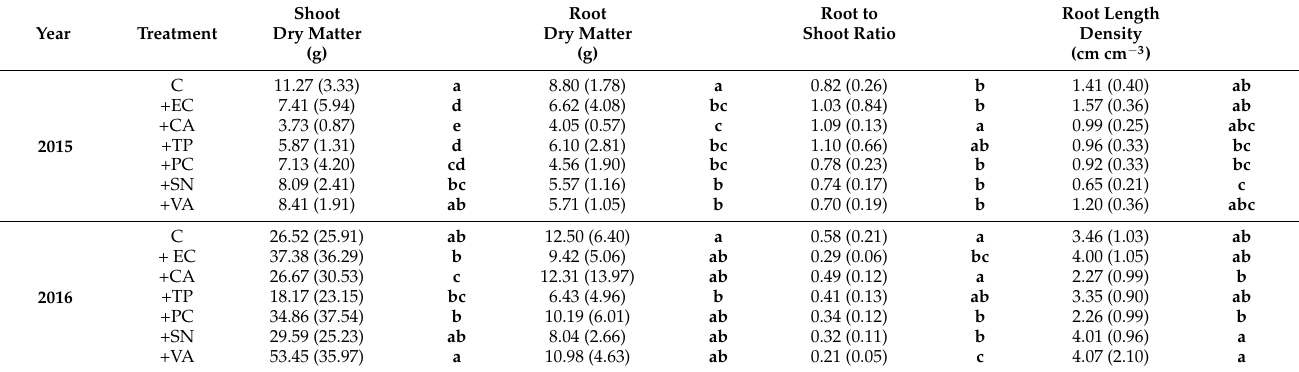
Table 2. Maize growth parameters (mean with standard deviation in parentheses) in weed-free growth (C) and mixed growth with weeds (+EC, +CA, +TP, +PC, +SN, +VA) in a pot experiment under semi-field conditions for 12 weeks at a P deficient soil in Northern Germany in 2015 and 2016. Lower letters indicate significant differences ( p < 0.05, Kruskal Wallis test, n = 42). (C: control, +EC: maize + Echinochloa crus-galli , +CA: maize + Chenopodium album, +TP: maize + Tripleurospermum perforatum , +PC: maize + Polygonum convolvulus , +SN: maize + Solanum nigrum , +VA: maize + Viola arvensis